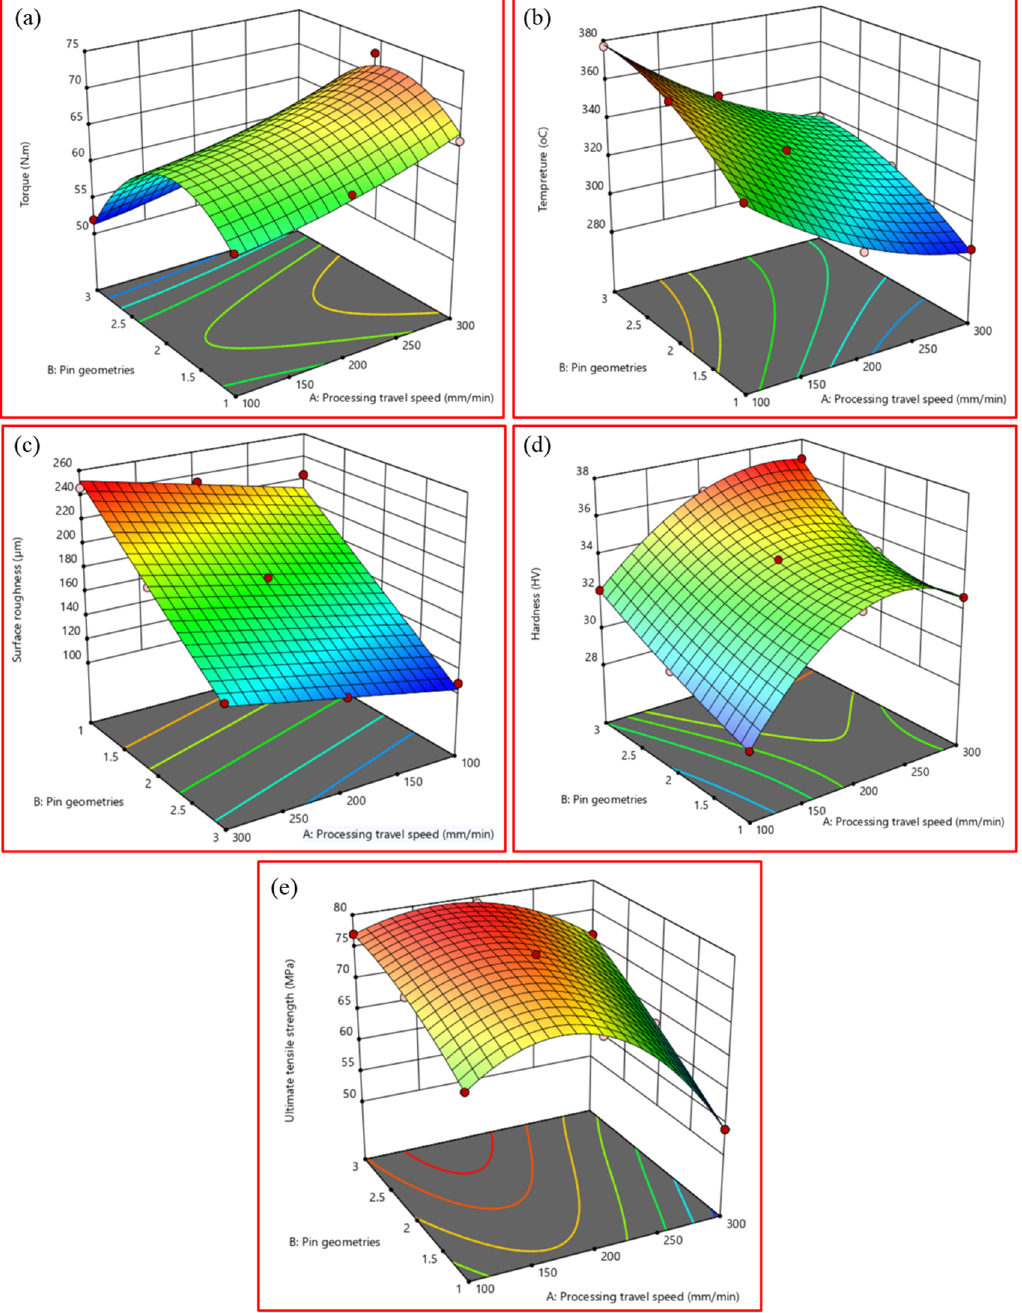
Figure 4. Three-dimensional contour diagrams for the ( a ) recorded machine torque, ( b ) PZ temperature, ( c ) surface roughness, ( d ) hardness, and ( e ) tensile strength.